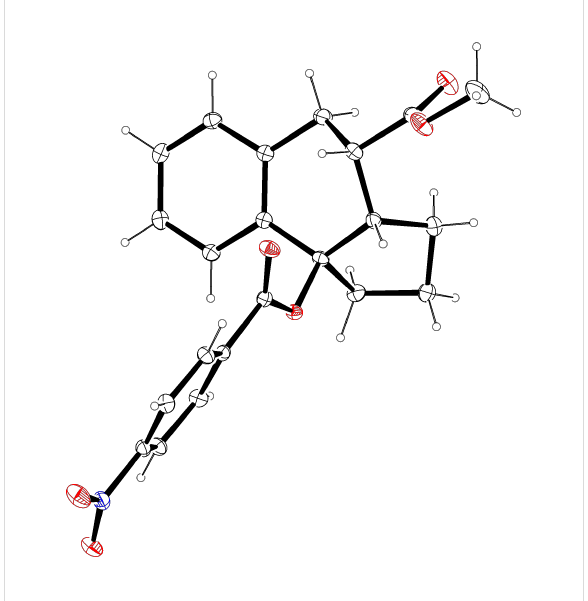
Figure 1: Molecular structure (ORTEP, [14]) of compound 12a (ther- mal ellipsoids at 50% probability).